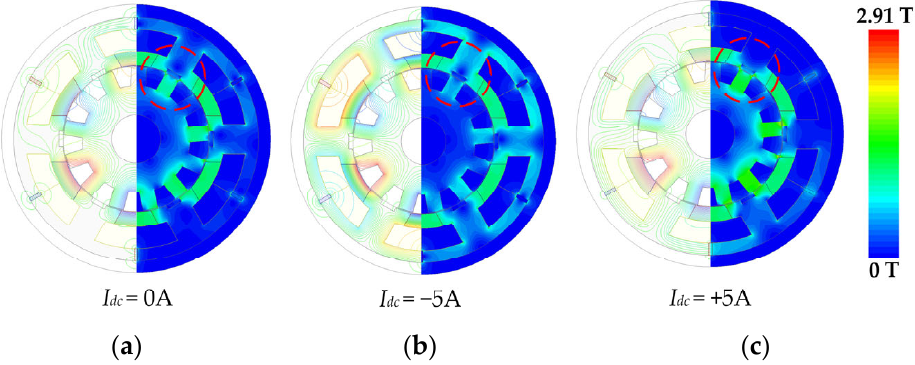
Figure 6. Open-circuit magnetic flux and field density of a multi-tooth HE-DSDPM with various I dc ; Figure 6. Open ‐ circuit magnetic flux and field density of a multi ‐ tooth HE ‐ DSDPM with various I dc ; (a) I dc = 0A, (b) I dc = − 5A, and (c) I dc = +5A. ( a ) I dc = 0 A, ( b ) I dc = − 5 A, and ( c ) I dc = +5